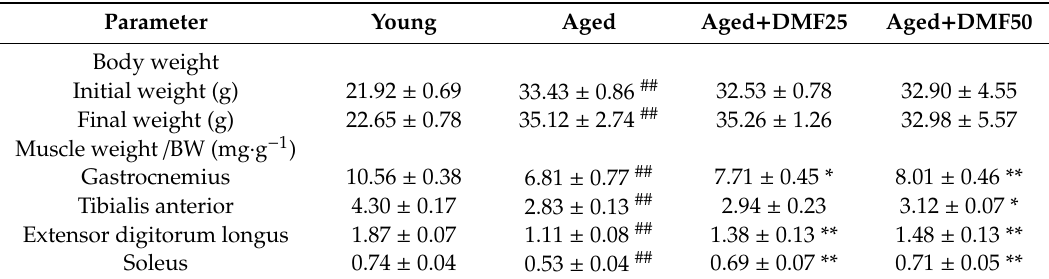
Table 2. Body and muscle tissue weights.